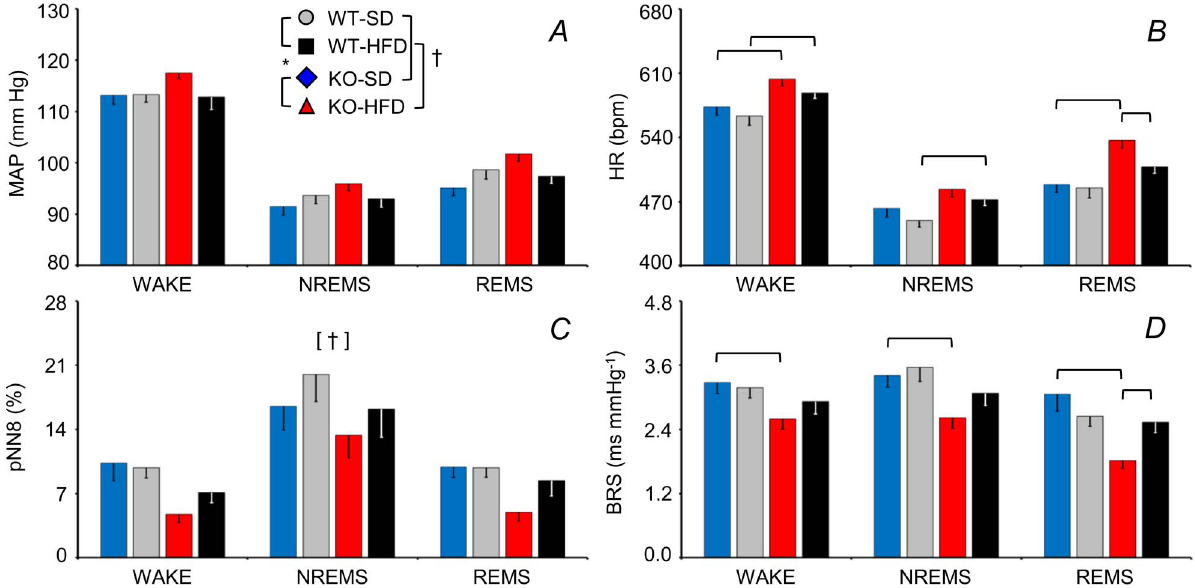
Figure 3. Sleep-related changes in arterial pressure, heart rate, cardiovagal modulation, and cardiac baroreflex sensitivity. Panels A- D show the mean values of MAP and HR, pNN8 (an index of cardiac vagal modulation), and spontaneous cardiac baroreflex sensitivity (BRS) during epochs of WAKE, non-rapid-eye-movement sleep (NREMS) and rapid-eye-movement sleep (REMS) averaged over 48 hours including light and dark periods. Data are means 6 SEM for KO and WT mice fed a SD or a HFD, with n=9–10 per group. The [ { ] symbol indicates a significant main effect of diet ( P , 0.05, ANOVA). Horizontal brackets indicate significant pairwise comparisons ( P , 0.05, t -test). For other abbreviations and symbols see Figure 1. Detailed ANOVA results are reported in Table S2.